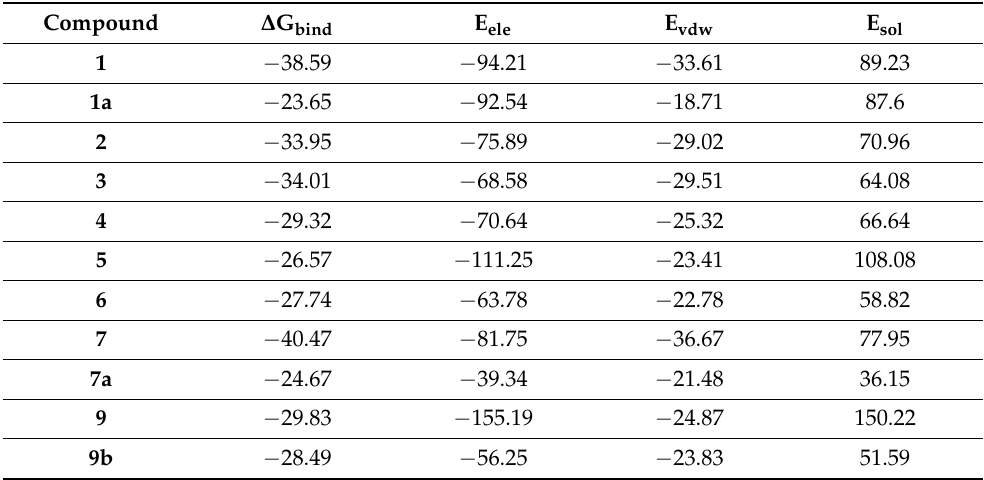
Table 6. Binding free energy (kcal/mol) and its components of docked compounds to the protein